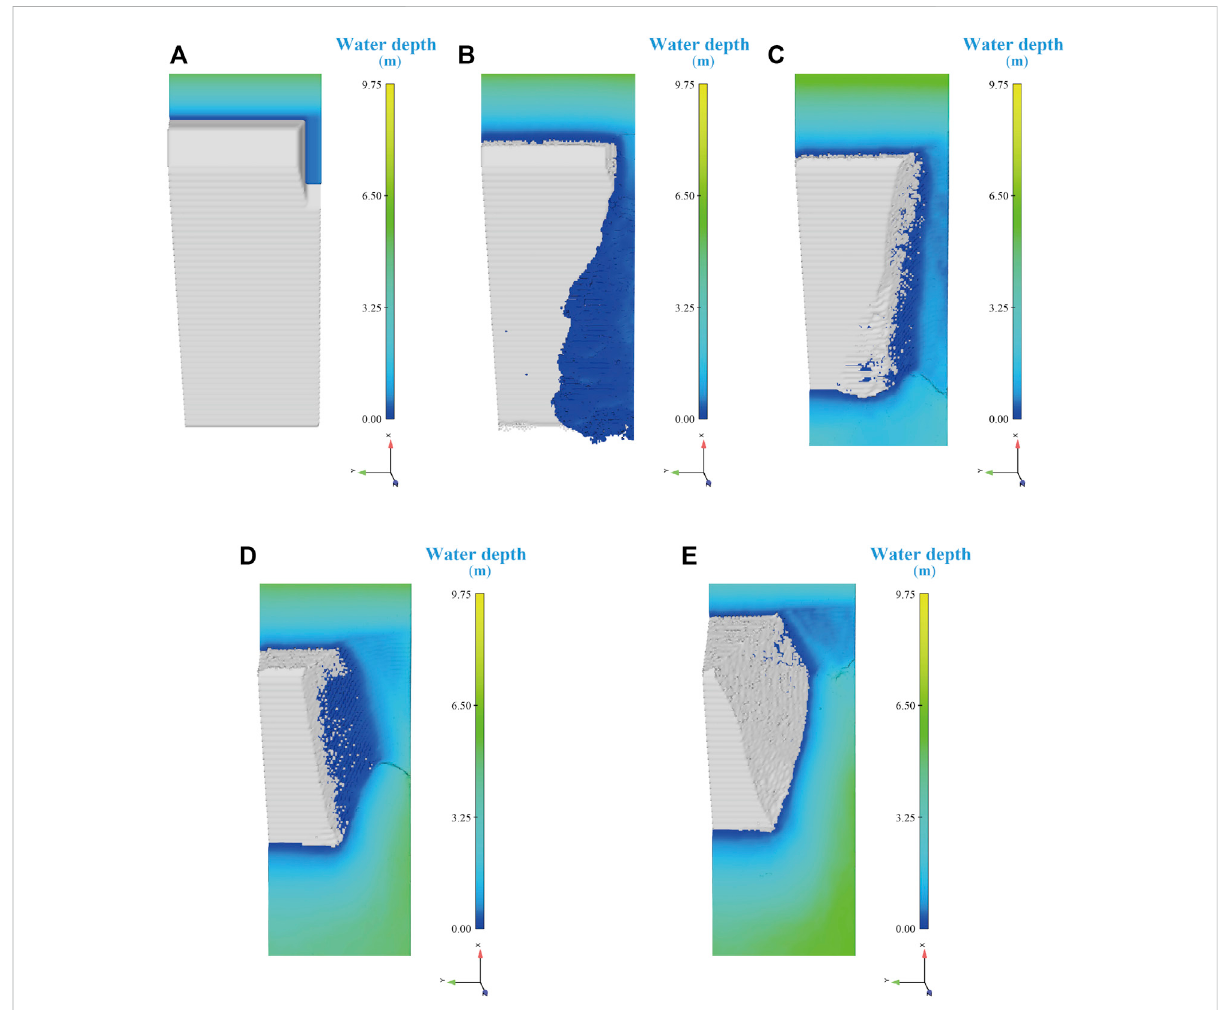
FIGURE 9 Typical top view of the dam body shape at each stage of the numerical model. (A) The initial moment of dam failure. (B) Stage 1. (C) Stage 2. (D) Stage 3. (E) Stage